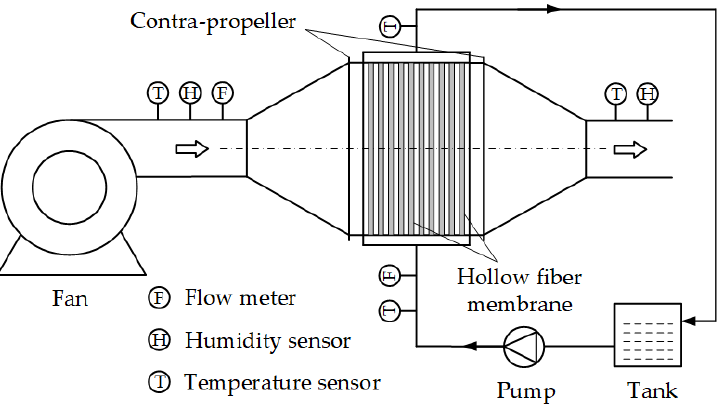
Figure 1. Schematic diagram of the hollow fiber membrane evaporative cooling system.